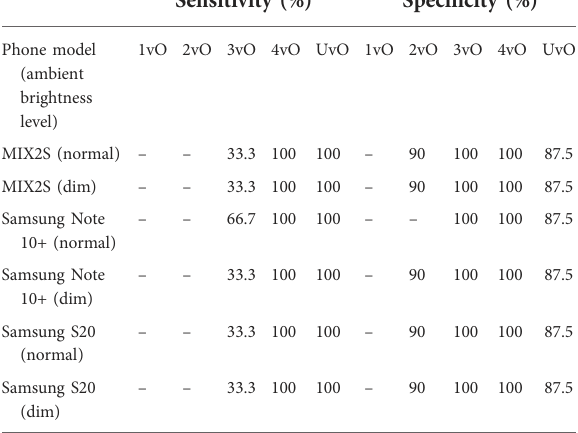
TABLE 4 Per-class spec fi city and sensitivity of the implemented model in three different android phones at two different ambient brightness levels on the test set